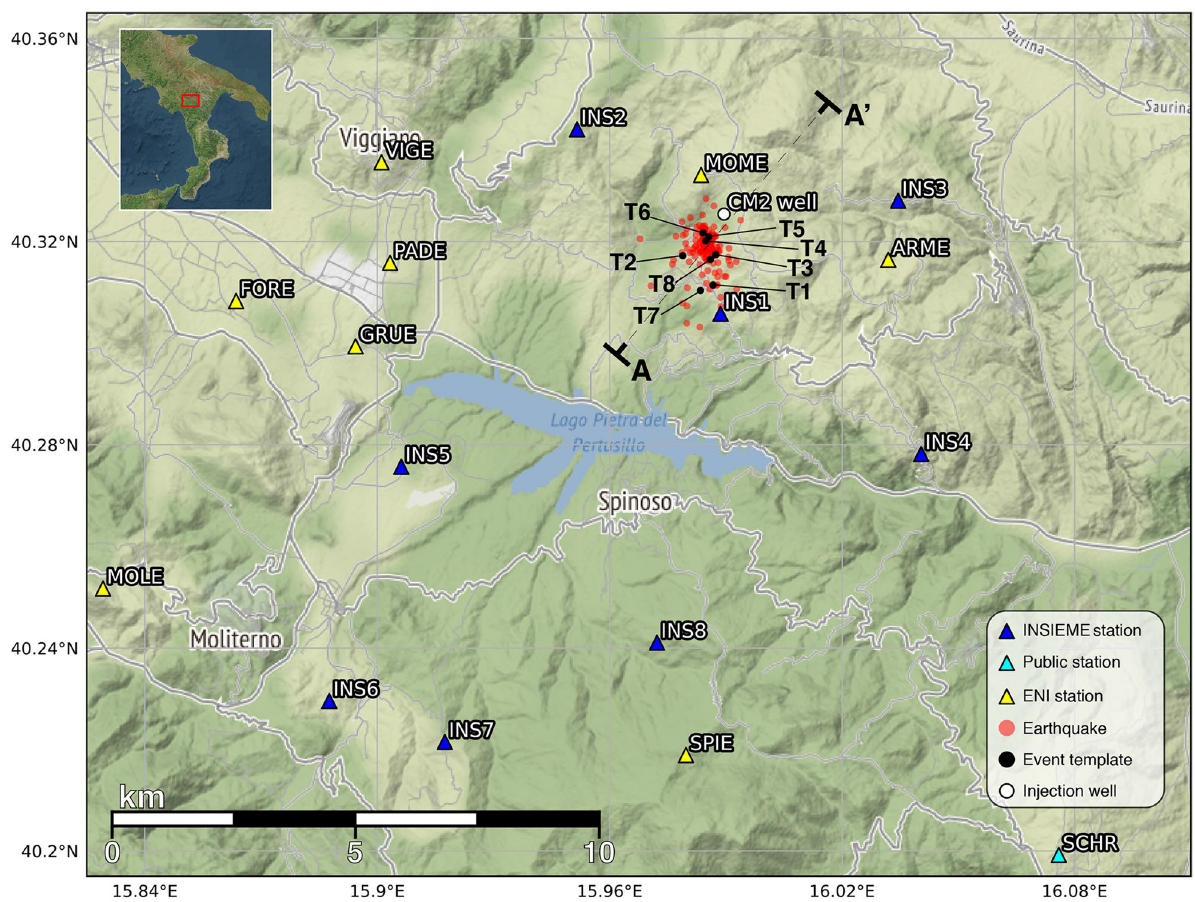
Figure 1. Location in the High Agri Valley (southern Italy) of the fluid injection induced seismicity cluster (red circles) analyzed in this study. Master events (T1–T8) of Supplementary Table S1 are displayed with black circles. Blue triangles represent the stations of the INSIEME seismic network; other public and private stations are represented with cyan and yellow triangles, respectively. The Costa Molina 2 (CM2) injection well is displayed with a white circle. AA ′ indicates the trace of the vertical cross section reported in Figs. 4 and 6. [The maps have been generated using Cartopy (https:// scito ols. org. uk/ carto py/ docs/ latest/) and Matplotlib (https:// matpl otlib.